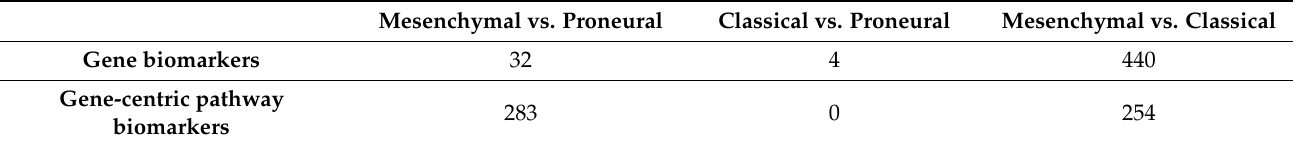
Table 3. Best individual gene and gene-centric pathway biomarkers identified for the comparisons of GBM molecular